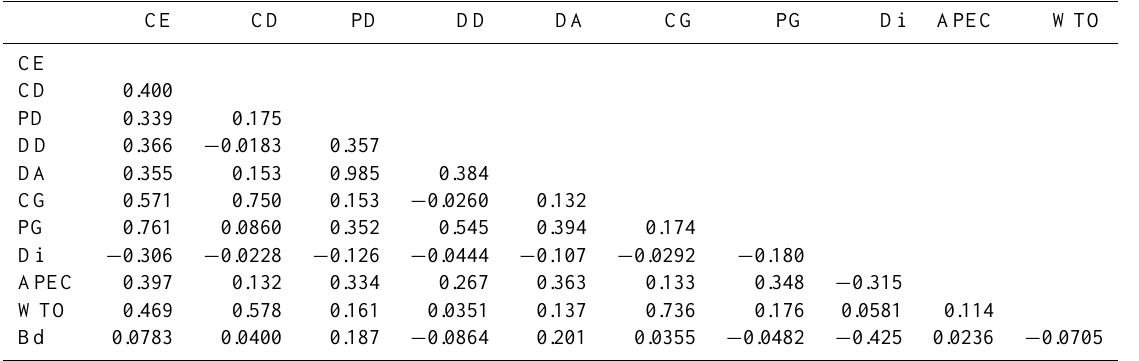
Table 3. The correlation matrix for China as an